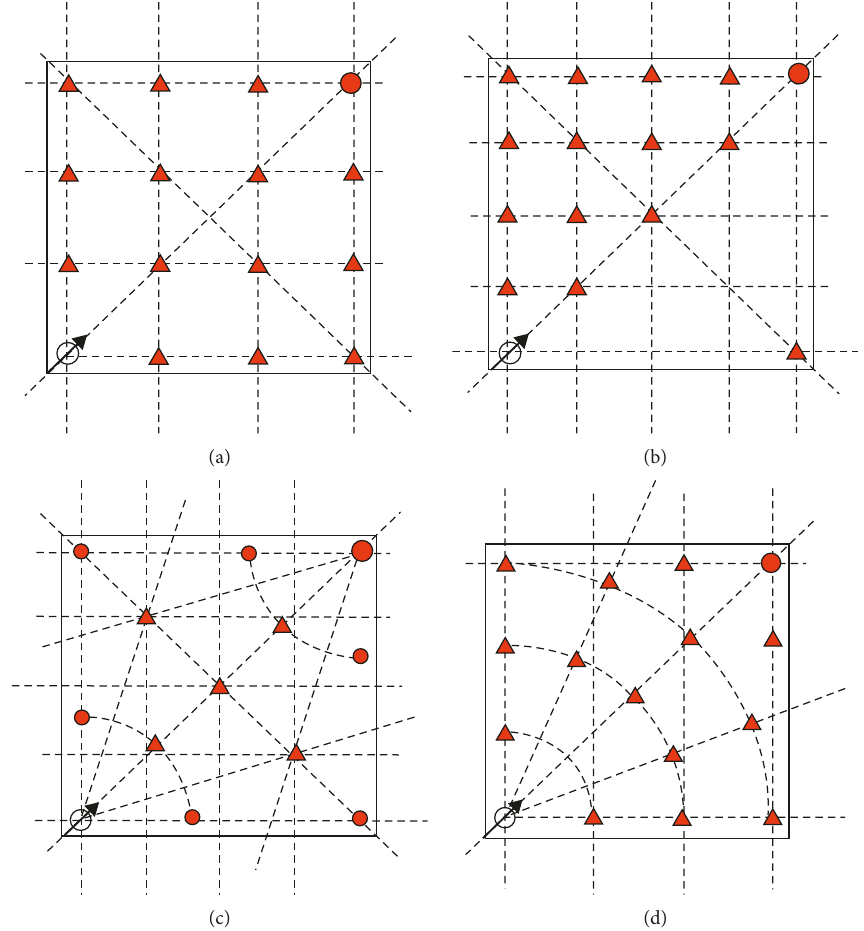
Figure 1: Available measurement point configurations. (a) Full-Matrix. (b) Semimatrix. (c) Side Bidirectional Axis. (d) Full+One-way